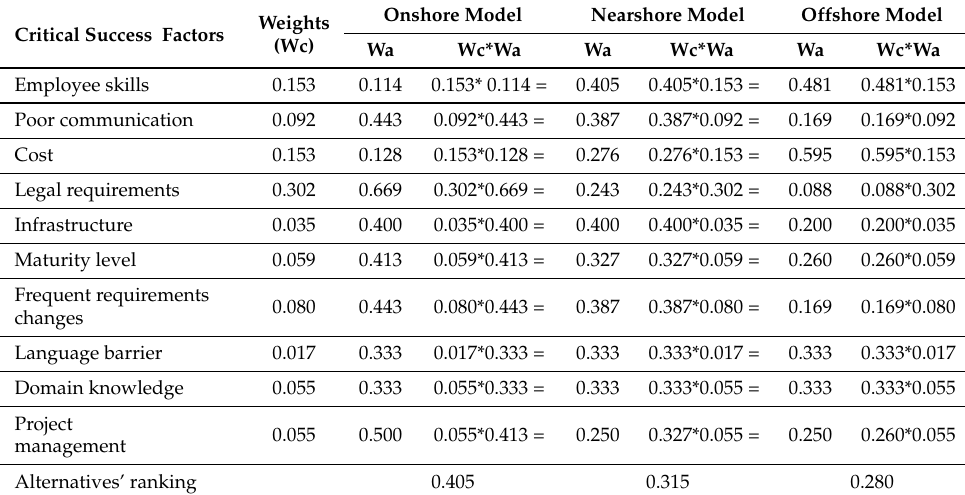
Table 13. Decision Matrix: calculating the ranking of